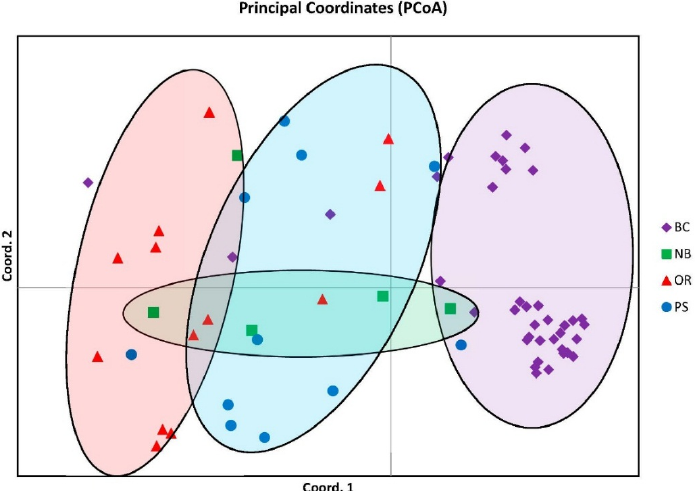
Figure 1. Principal coordinate analysis similarity matrix (PCoA) accounting for 57.11% of the genetic variation. Note four distinct clusters but with NB overlapping over the other